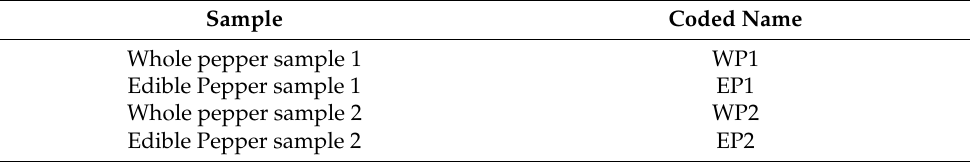
Table 1. Samples and coded